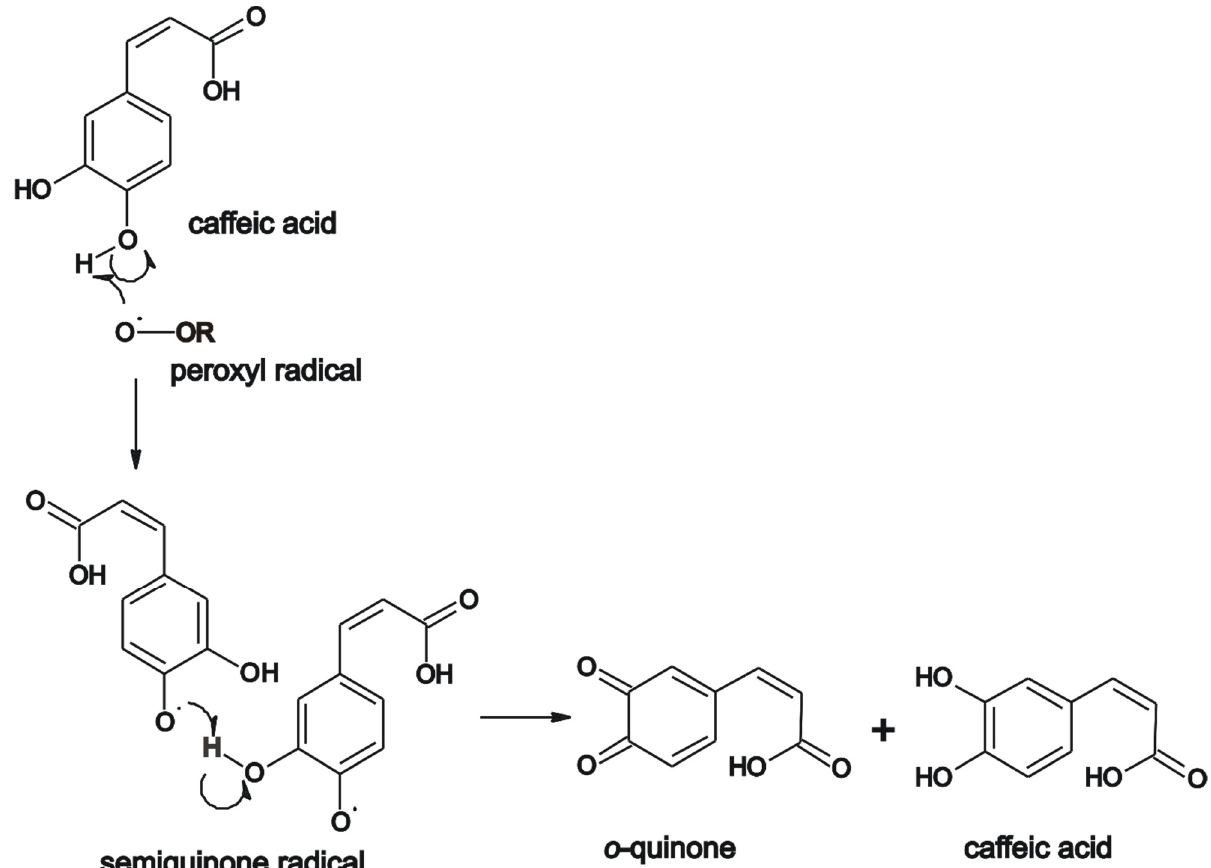
Table 6. Determination of the antioxidant activity of CA and FA